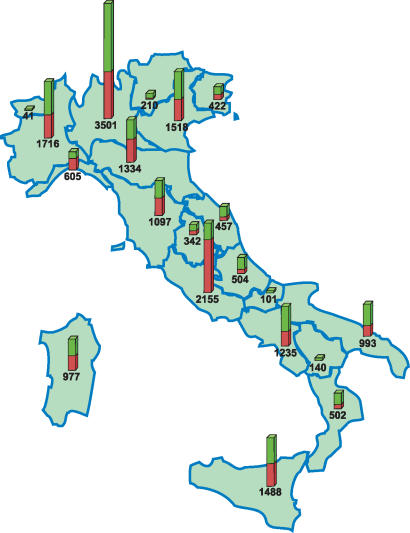
Doctors Using ECCE by Region Red: urban areas; green: rural areas.